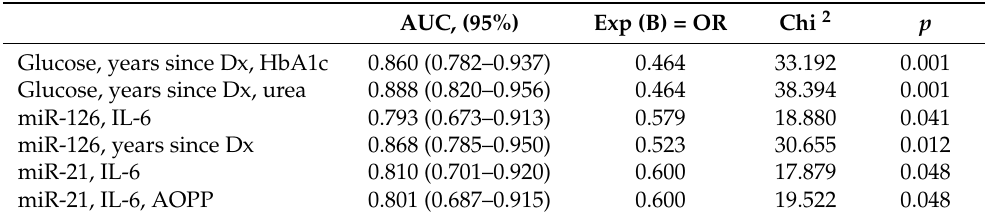
Table 7. This table represents the predictive values for developing vascular diabetic complications among all participants, calculated by binary logistic regression analysis .